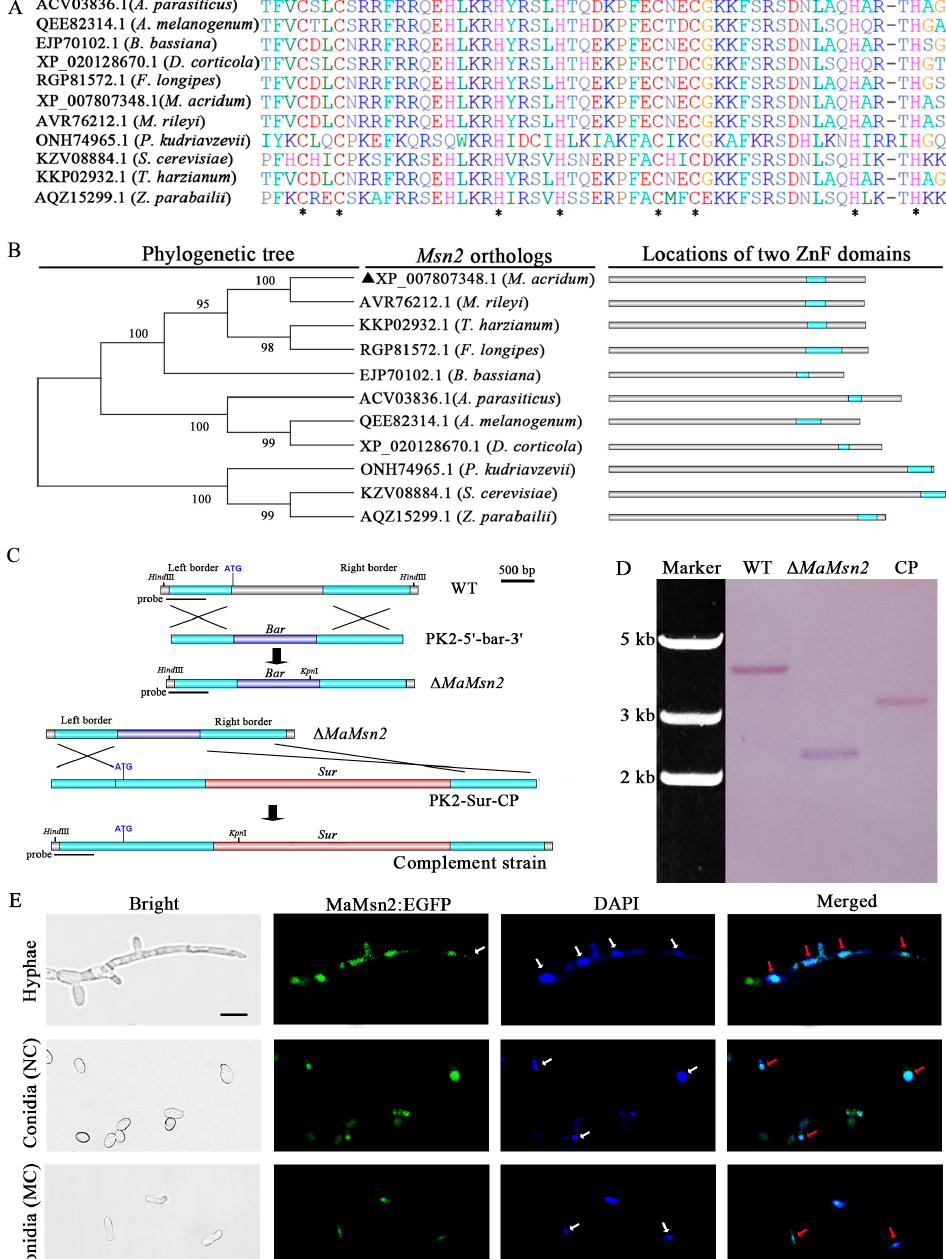
Figure 1. Sequence analysis and intracellular localization of MaMsn2. ( A ) Msn2 protein sequence alignment. The Msn2 homologous genes are from Aspergillus parasiticus , Aureobasidium melanogenum , Beauveria bassiana ARSEF 2860, Diplodia corticola , Fusarium longipes , M. acridum CQMa 102, M. rileyi , Pichia kudriavzevii , Saccharomyces cerevisiae , Trichoderma harzianum and Zygosaccharomyces parabailii . Asterisks indicate conservative C and H loci. ( B ) Main domains and phylogenetic relationships of Msn2. ▲ : Msn2 in M. acridum . ( C ) The knockout (upper) and complement (lower) schematic diagram of MaMsn2. ( D ) The Southern blot verification of ∆ MaMsn2 and CP strains. Restriction enzymes Hind III and Kpn I were used to digest genomic DNAs. Probe location is shown in the diagram. ( E ) LSCM images of subcellular localization of MaMsn2:EGFP. Hyphae were collected from 1/4 SDAY grown for 18 h and conidia were collected on 1/4 SDAY and SYA grown for 48 h. NC: Conidia produced on 1/4 SDAY, MC: Conidia produced on SYA. White arrows: DAPI-stained nuclei, red arrows: merged nuclei. Scale bar indicates 5 µ